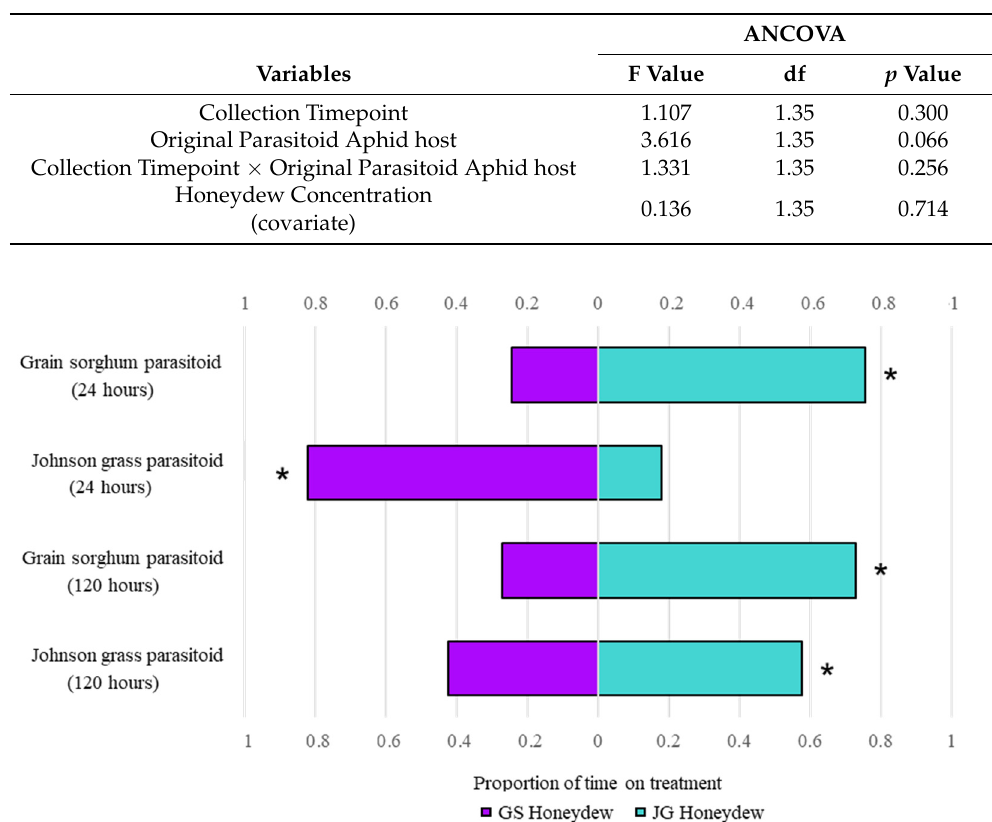
Table 4. Neither Timepoint nor Original Parasitoid Aphid Host Mediate Parasitoid Preference (Measured as the Relative Proportion of Time Spent on Each Treatment) for Grain Sorghum versus Johnson Grass Honeydew.